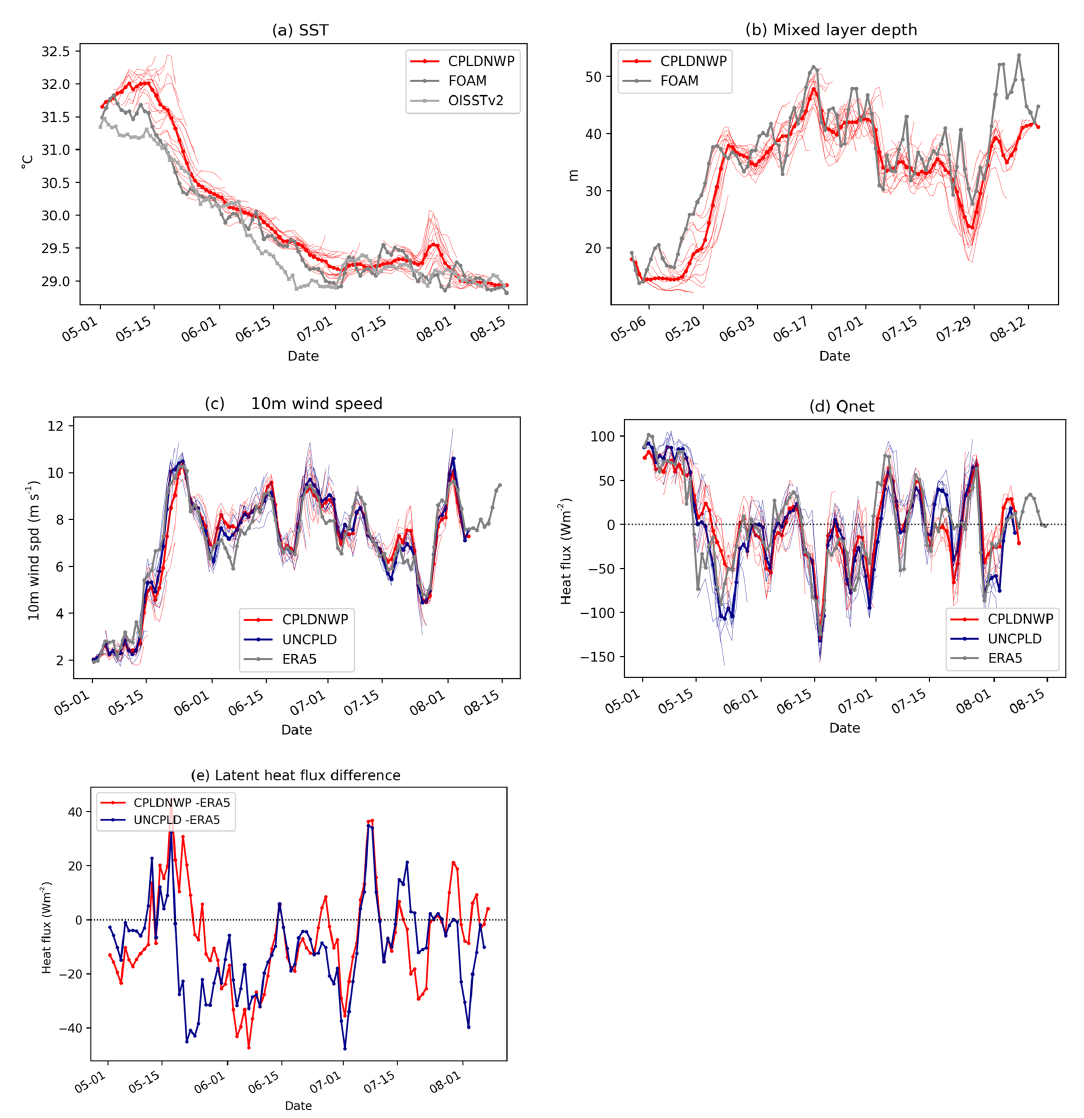
Figure 13. Time series of daily forecasts initialised between 1 May and 31 July 2016. Individual forecasts (thin lines) are averaged at each validity time (“date”) into a mean forecast (coloured heavy line). Grey lines are from analyses. Lines show area averages over EEIO northern box (2–15 ◦ N, 87–96 ◦ E; see Fig. 8e) (a) SST from CPLDNWP and FOAM analyses, up to day 15; (b) mixed layer depth calculated using daily mean temperature and salinity from CPLDNWP and FOAM analyses, up to day 15; (c) 10m wind speed from CPLDNWP (red) and UNCPLDNWP (blue) up to day 7; (d) net surface heat flux from CPLDNWP (red) and UNCPLDNWP (blue) up to day 7. A positive (negative) value denotes net flux into (out of) the ocean; (e) mean forecast error of latent heat flux in CPLDNWP and UNCPLDNWP forecasts, relative to